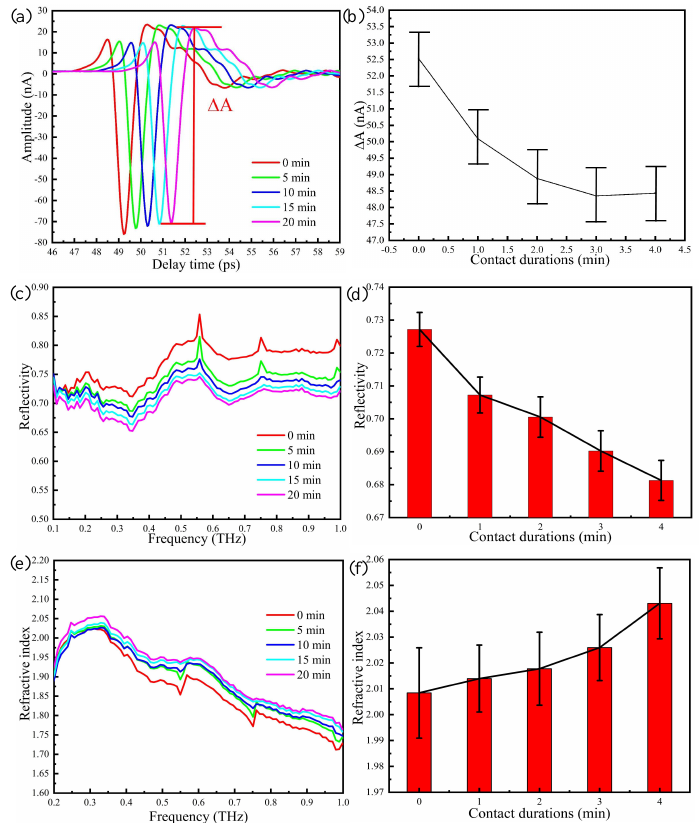
Figure 6. THz-ATR spectra with the thumb on region 2 of the prism and different durations of the contact between the thumb and the prism: ( a ) the time domain spectra, ( b ) peak-to-peak amplitude, ( c ) the reflection spectra, ( d ) error tree diagram of the reflectance at 0.6 THz, ( e ) the refractive index spectra, ( f ) error tree diagram of the reflectance at 0.6